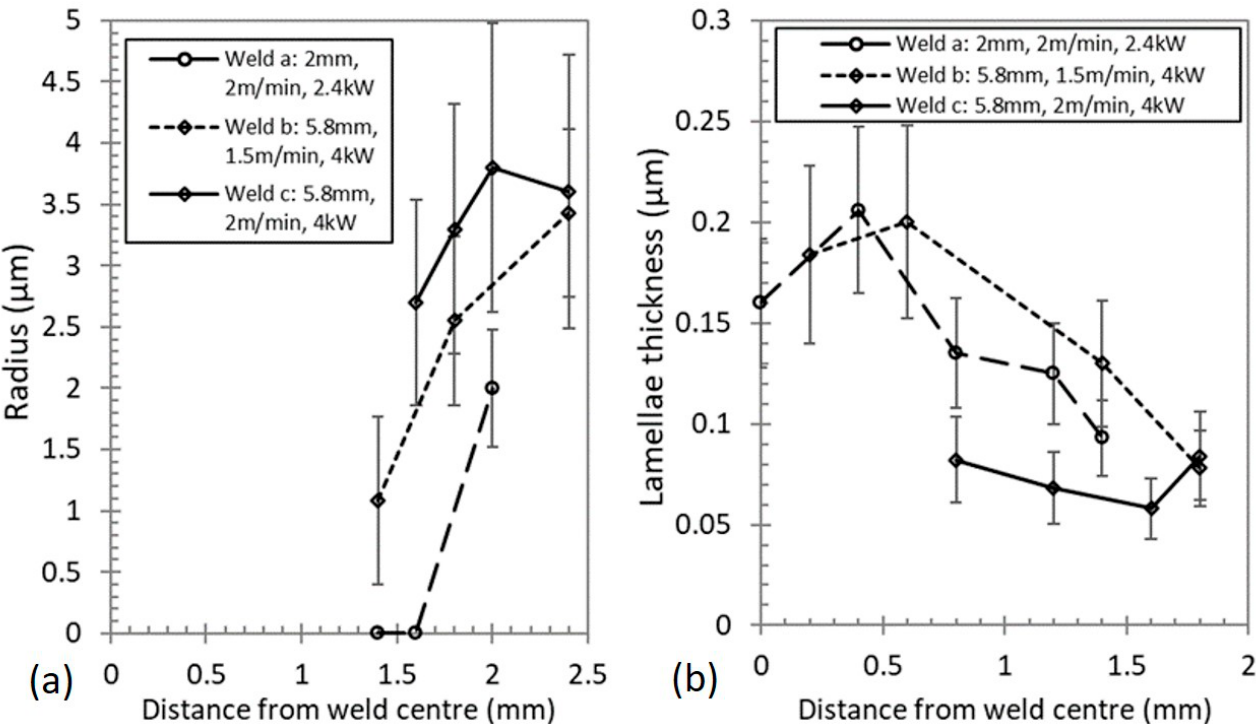
Figure 8 . The experimentally measured ( a ) equiaxed grain radius and ( b ) lamellae thickness after welding in plates with an initially equiaxed morphology.